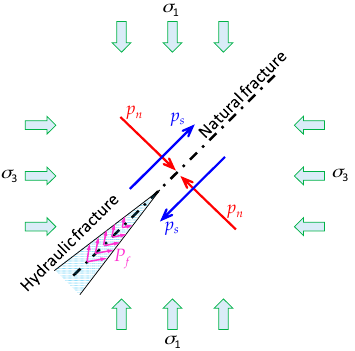
Figure 16. Schematic of the analytical model for calculating the break pressure of discontinuous natural fractures. p f is the break pressure; p n and p s are the normal compressive stress and the tangential shear stress of discontinuous natural fractures.